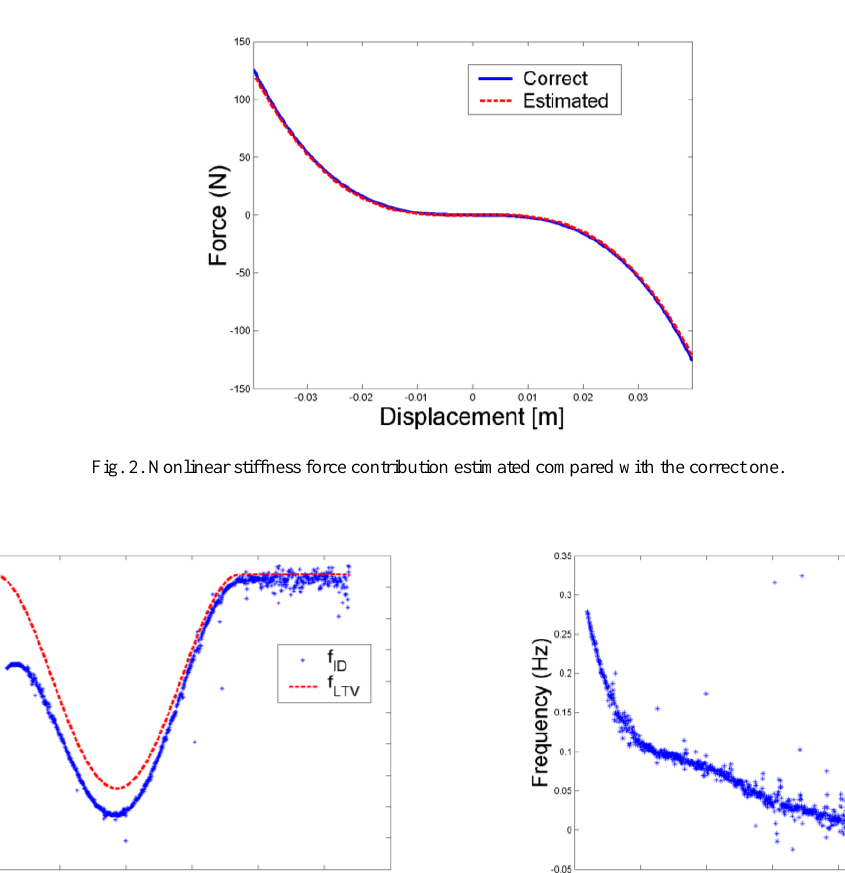
Fig. 1. Displacements at the middle point of the beam (a) and reconstructed first natural frequency with that identified from the ST-SSI method (b).